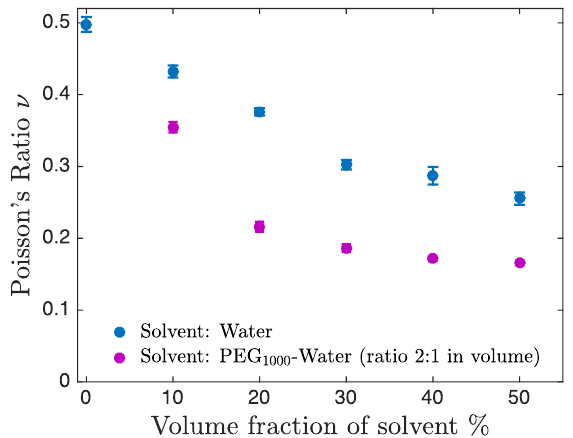
Figure 5. Evolution of the Poisson ratio of hydrogels fabricated from different photosensitive solutions as a function of the solvent volume fraction. Two different solvents are shown: water (blue markers) and a solution of PEG M n = 1000 g/mol:water at a volume ratio of 2:1 (purple